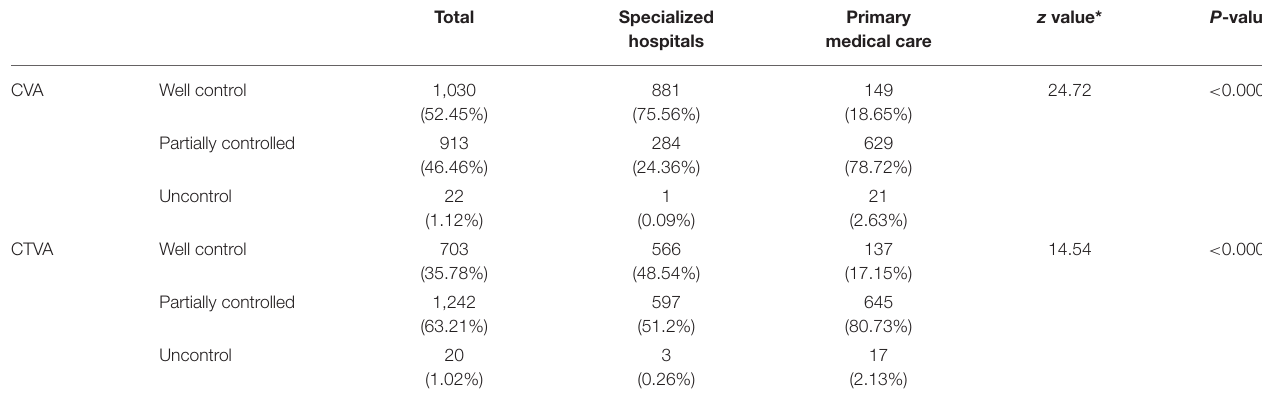
TABLE 3 | Control level of CVA and CTVA.